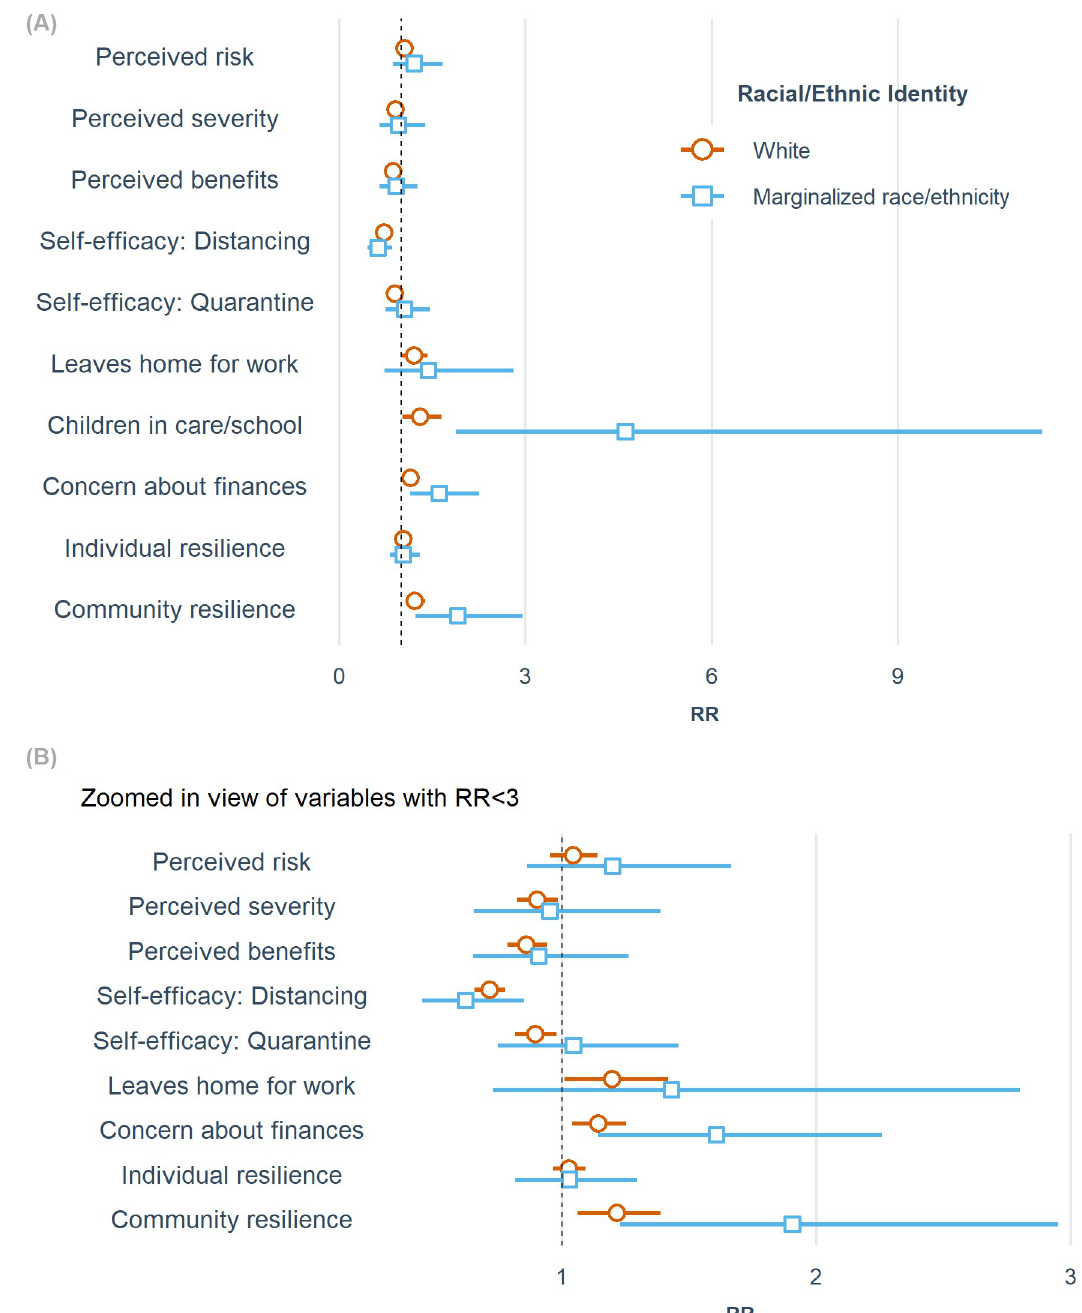
Fig 2. Health Belief Model and resilience constructs stratified by race/ethnicity for the family cohort (C1). (A) shows all constructs. (B) is limited to those variables with rate ratio (RR) estimates < 3.0 for closer examination. RRs were estimated from negative binomial models adjusted for age (linear and quadratic terms), gender, income, state of residence, week surveyed, and number of COVID-19-related symptoms experienced in the past 30 days. Bars indicate 95% confidence